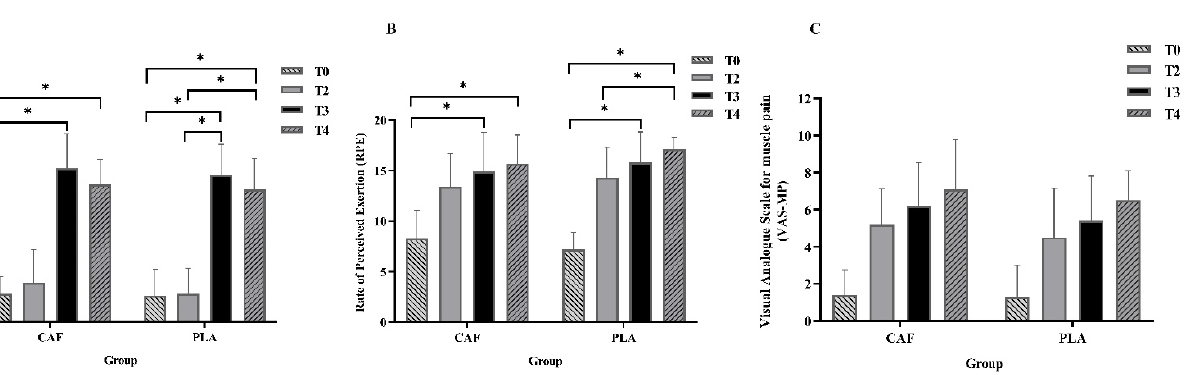
Table 3. Results of heart rate.